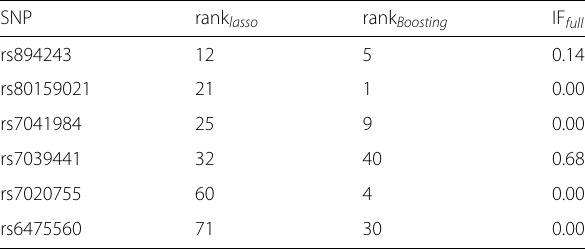
Table 2 Overlap of top 100 selected SNPs by the lasso and synthesis